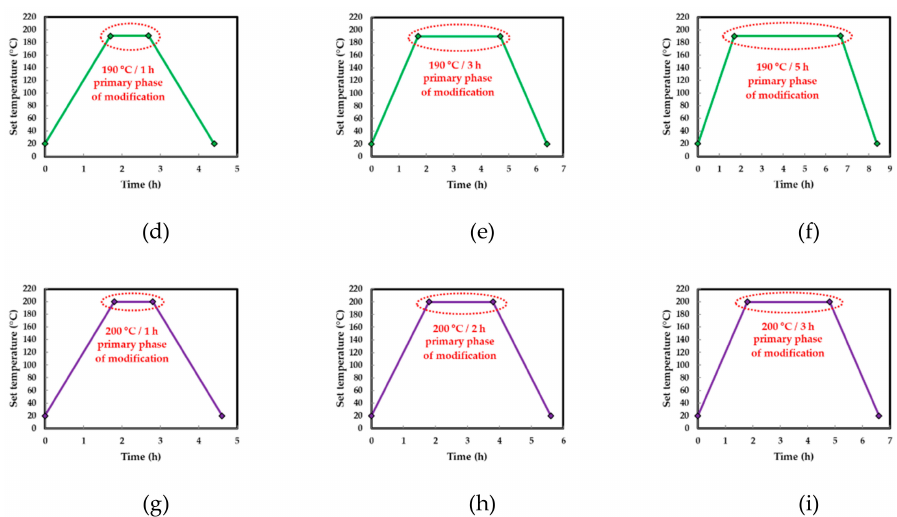
Figure 1. Diagram of the heat-treatment procedure at 170 ◦ C / 1 h ( a ), 170 ◦ C / 3 h ( b ), 170 ◦ C / 5 h ( c ), 190 ◦ C / 1 h ( d ), 190 ◦ C / 3 h ( e ), 190 ◦ C / 5 h ( f ), 200 ◦ C / 1 h ( g ), 200 ◦ C / 2 h ( h ), 200 ◦ C / 3 h ( i